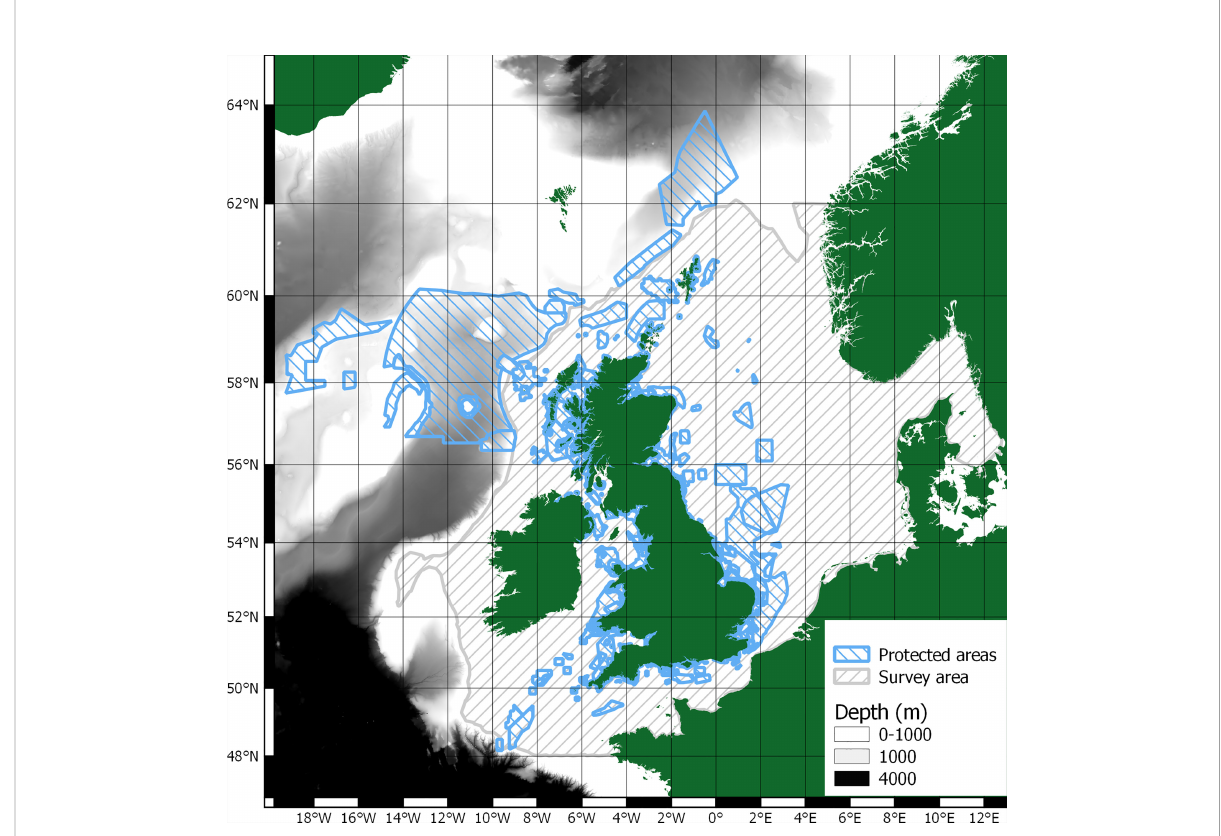
FIGURE 2 Survey area, protected areas, and